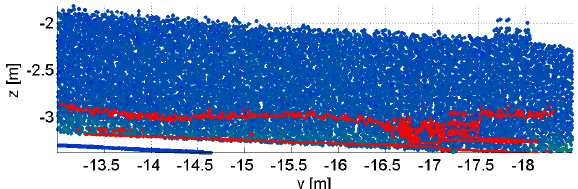
Figure 12: Example of segmentation results: a portion of the seg- mentation boundaries (red lines) for Fig. 8 remapped in the 3D space. Boundary lines are superimposed to the cloud points ac- quired by means of TLS. Observation direction is approximately orthogonal to the analyzed